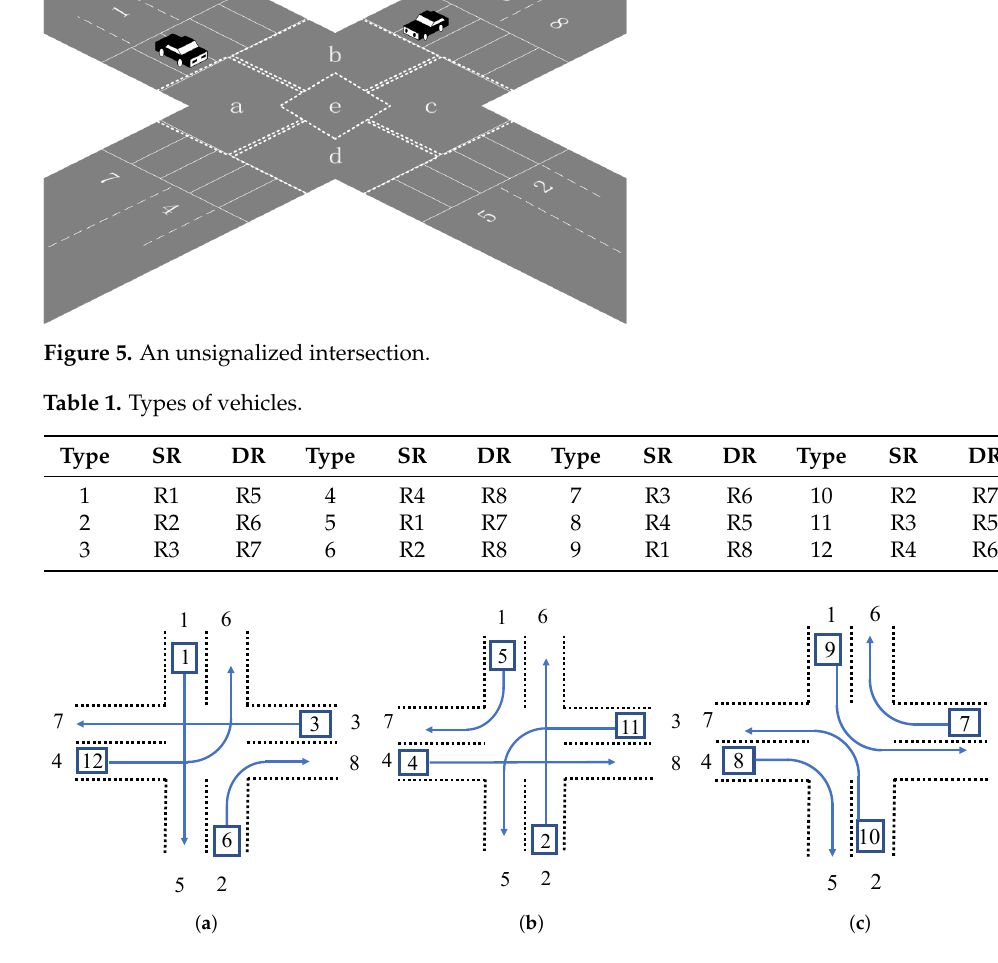
Figure 6. Different vehicle types; ( a ) Vehicle types of 1, 3, 6, and 12; ( b ) Vehicle types of 2, 4, 5, and 11; ( c ) Vehicle types of 7, 8, 9, and